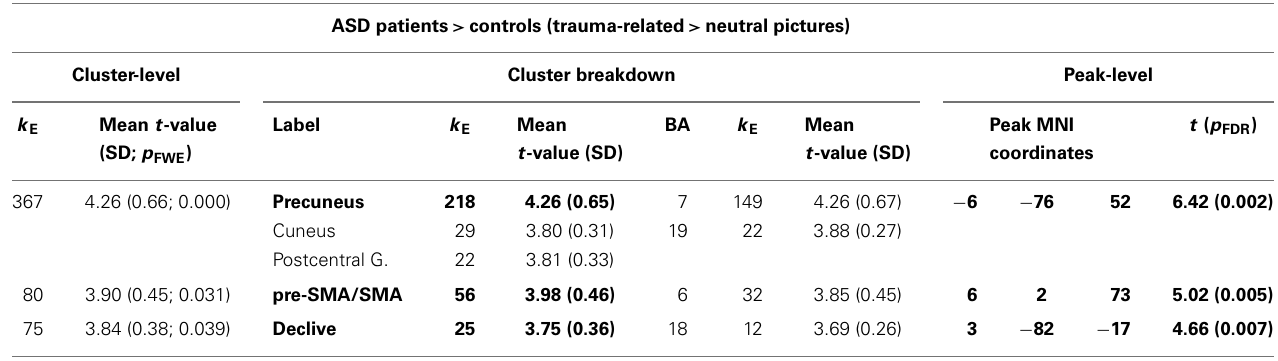
Table 2 | Comparison betweenASD patients and controls with regard to their response to trauma-related compared to neutral pictures